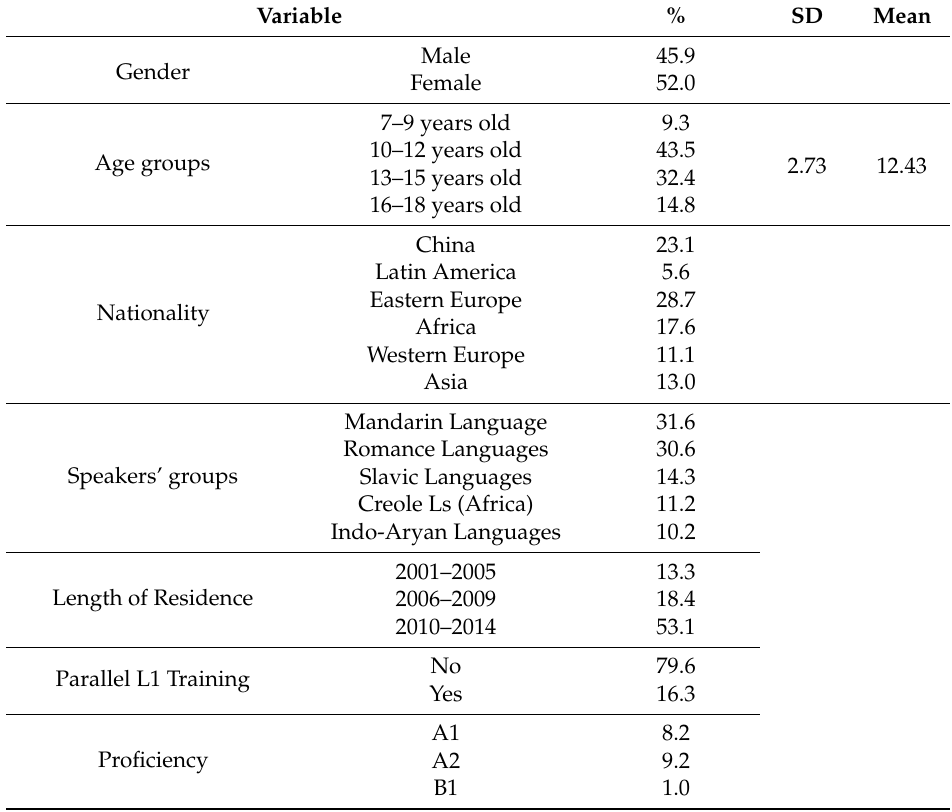
Table 1. Sociodemographic